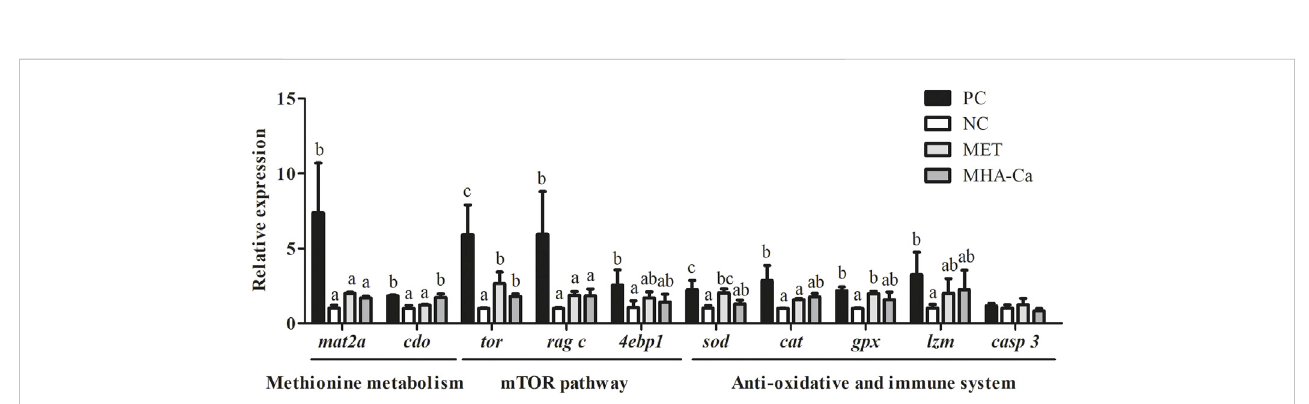
FIGURE 2 Relative expression of methionine metabolism, mTOR signaling pathway, anti-oxidative and immune system related genes in hepatopancreas of L. vannamei fedwithfourdiets.AllgeneexpressionoftheNCgroupwasstandardizedasabout1.Allexpressionvaluesarenormalizedwith β -actin (n=3),withSD denoted by vertical bars. Different letters over columns indicate signi fi cantly different ( p <